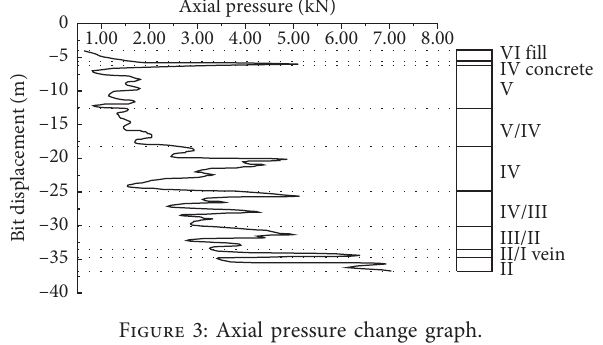
Figure 3: Axial pressure change graph.